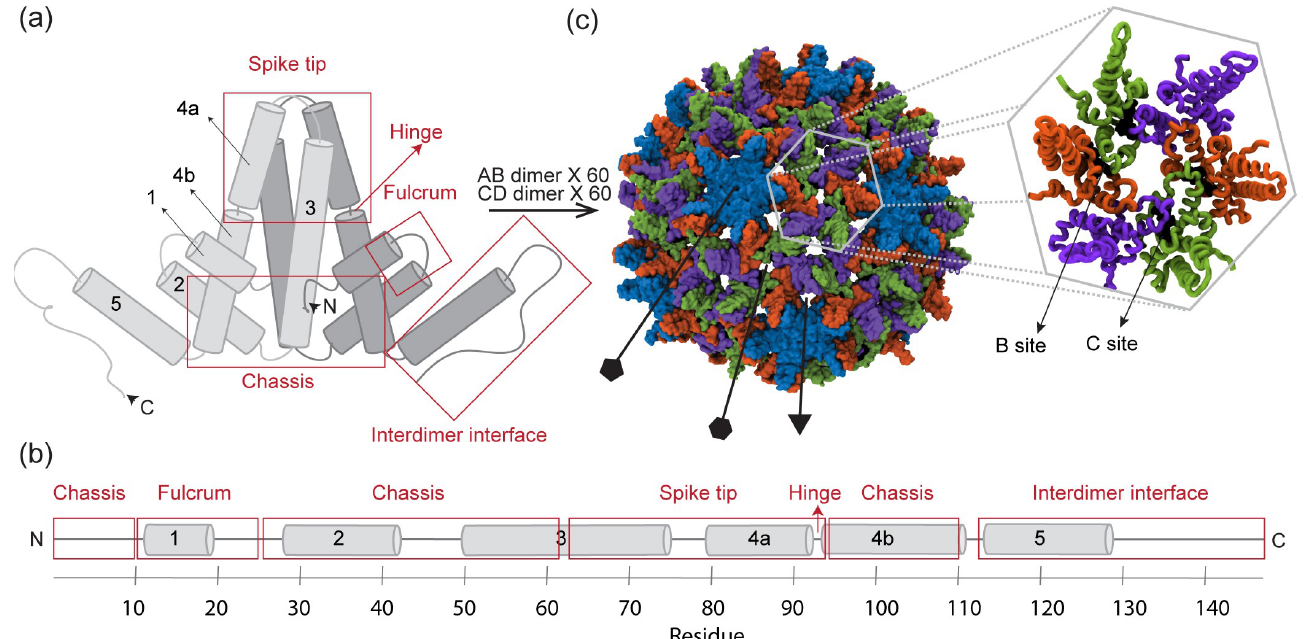
Figure 1. HBV core protein dimer and capsid. ( a , b ) Schematics of Cp149 dimer, illustrating the five typical α -helices, labeled 1–5 from the N- to C-terminus. Established dimer sub-domains [11] are indicated, including the chassis, fulcrum, hinge, spike tip, which forms part of the intradimer interface, and interdimer interface, where helix 5 of neighboring chains overlap and form a CpAM binding pocket. ( c ) The T = 4 icosahedral capsid incorporates 120 dimers, whose chains can occupy four quasi-equivalent positions, designated A (blue), B (orange), C (green), and D (purple). Capsid-incopororated dimers are, thus, denoted AB and CD. Five copies of A chains form the 12 capsid pentamers, while two copies of B, C, and D chains form the 30 capsid hexamers. The AT130-bound crystal structure (PDB 4G93 [10], shown) indicates that the CpAM binds the capsid in B sites, between B and C chains, and C sites, between C and D